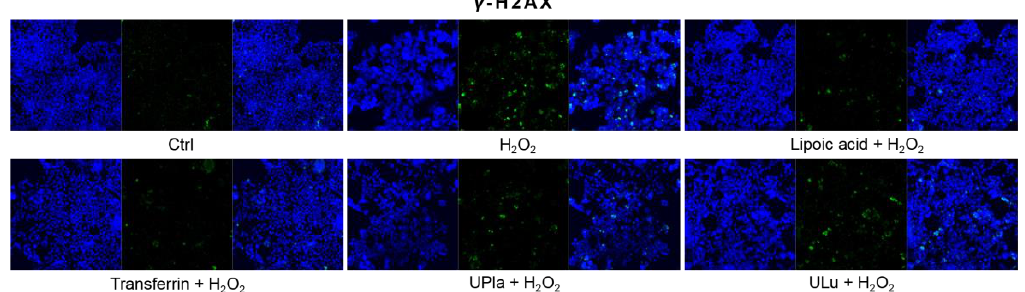
Figure 8. The expression of senescence markers was monitored by immunofluorescence staining in HEK293 cells upon treatment with H 2 O 2 , with or without single substances. Cells incubated with different senescence marker antibodies displayed green fluorescence and the nucleus was stained by DAPI. The results represent similar results from three independent experiments. Similarly, H 2 O 2 -treated HepG2 cells (Figure 9) became senescent and showed an increase in p16, p21, HMGB1, MMP3, IL-6, and γ -H2AX expression. Pre-treatment with ULu and transferrin modulated the p16 increase. ULu and lipoic acid alleviated the rise in HMGB1 levels, whereas UPla and ULu as well as lipoic acid counteracted the MMP3 increase, and lipoic acid blunted the changes in IL-6 levels.